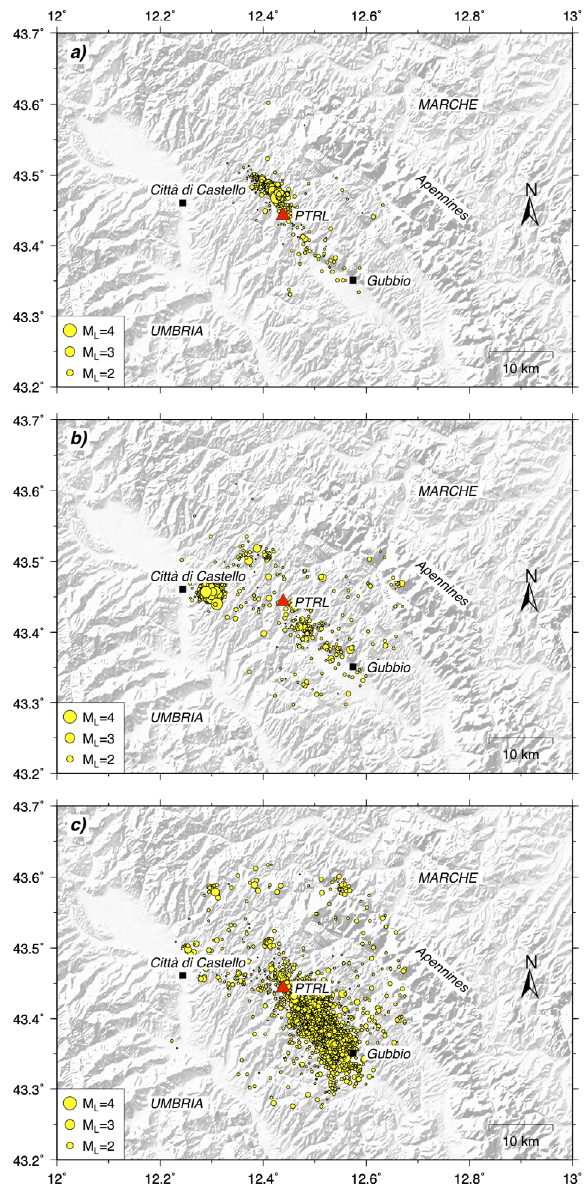
Figure 2. (a): Seismicity recorded by ISIDe [ISIDe 2010] between April 1, 2010 and April 30, 2010 with epicentral distance from the PTRL station (red triangle) of less or equal to 20 km (817 events); (b): the same as in panel (a) but between April 1, 2013 and May 31, 2013 (1653 events); (c): the same as in panel (a) but between August 1, 2013 and January 31, 2014 (5434 events). Plots were made using the Generic Mapping Tools version 4.2.1 (www.soest.hawaii.edu/ gmt; Wessel and Smith